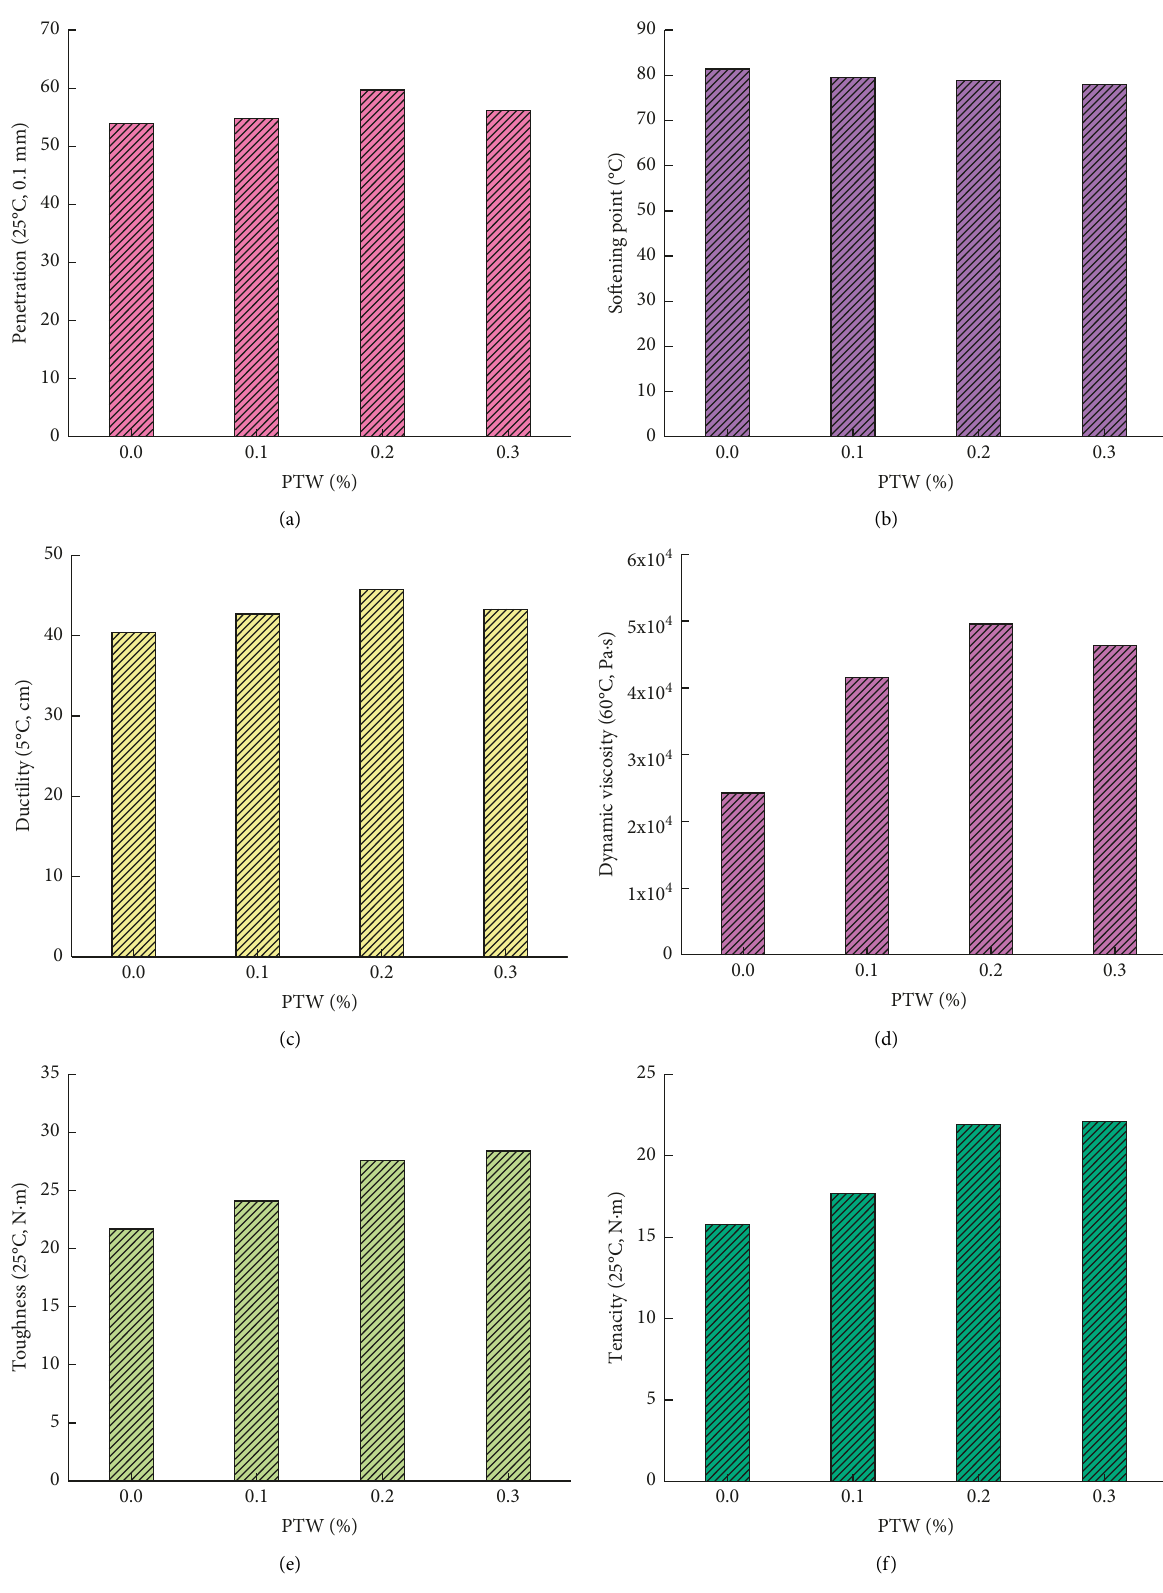
Figure 3: Test results of modified asphalt with different content of toughening